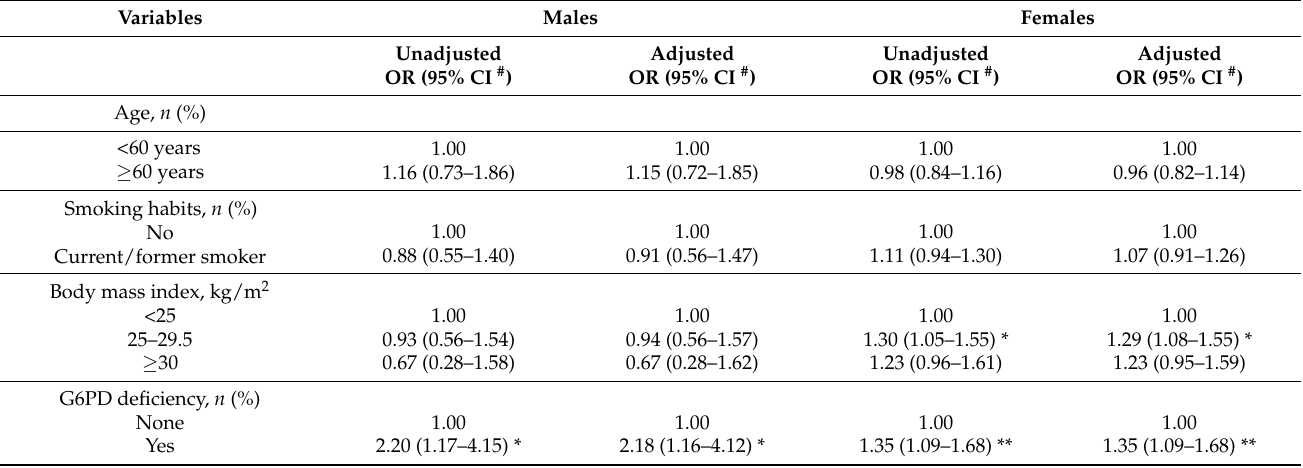
Table 4. Unadjusted and adjusted odds ratio (OR) for autoimmune thyroid disease (AITD) among 8696 patients stratified by